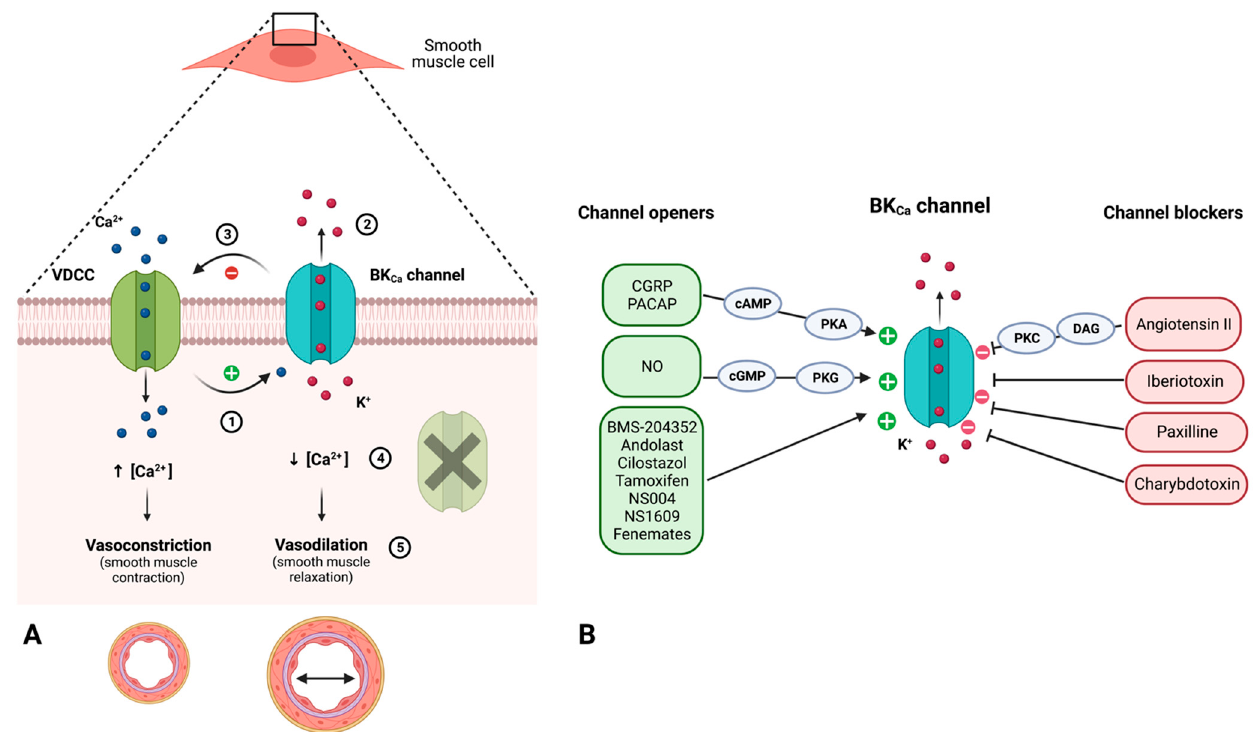
Figure 6. ( A ) The regulation of vascular tonus by BK Ca channels. ( B ) BK Ca channel openers and blockers . A : Opening of voltage dependent calcium channels (VDCC) causes influx of Ca 2+ ions and